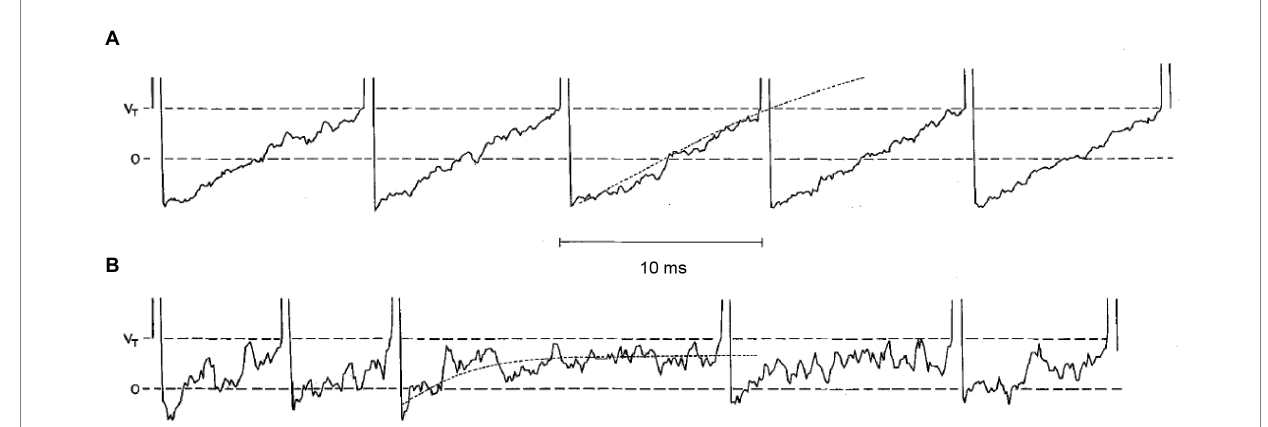
FIGURE 2 Simulations of five consecutive interspike voltage trajectories for a regular neuron in panel (A) , and for an irregular unit in panel (B) . Horizontal dashed lines are the resting potential (0) and the critical firing level (Vr). The dotted curves on the third interspike interval for each unit are the mean voltage trajectories. Reproduced with permission from Smith and Goldberg